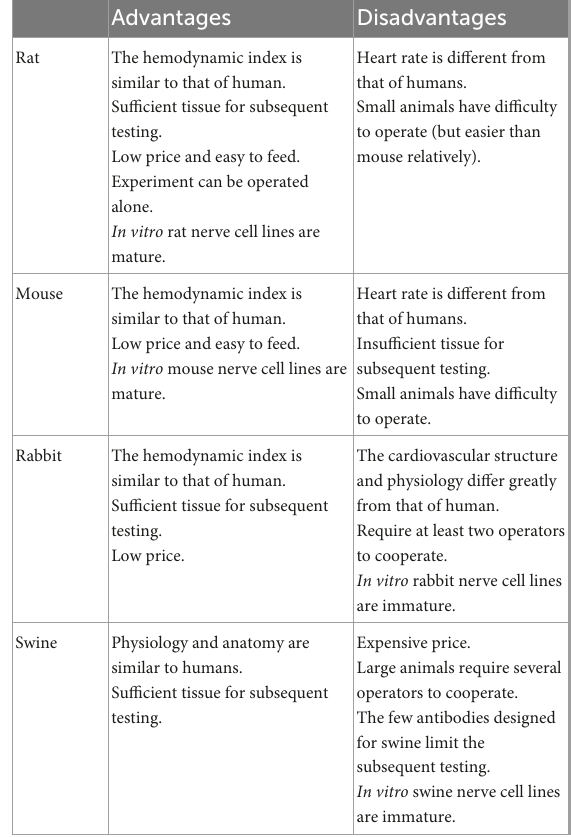
TABLE 1 Comparison of different animal cardiac arrest (CA) models. Advantages